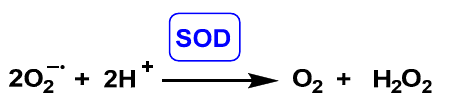
Figure 30. SOD disproportionation of superoxide to O 2 and H 2 O 2 .